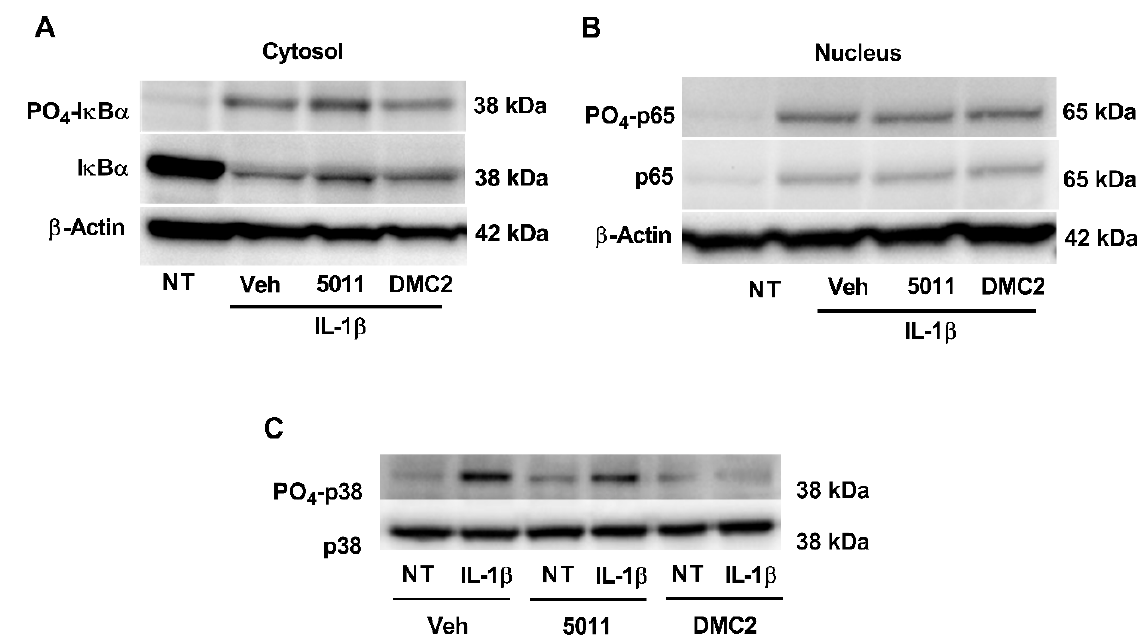
Figure 3. DMC2 reduces p38 MAPK phosphorylation but not phosphorylation of either I κ B α or p65. ( A – C ) 832/13 cells were treated with DMSO (Veh), PMI 5011, or DMC2 for one hour, followed by exposure to IL-1 β for 15 min. ( A ) Western blots for phospho-I κ B α (S32), total I κ B α , and β -actin (loading control). ( B ) Western blots indicating phosphorylation of p65 (S536), total p65, and β -actin. ( C ) Western blots showing phosphorylation of p38 MAPK (Thr180/Tyr182) and total p38 MAPK.